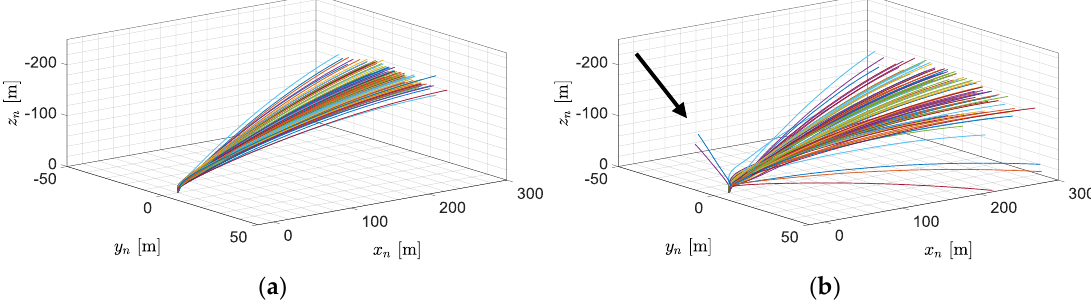
Figure 11. Projectile trajectories for various initial roll rate standard deviations. (a) 10°/s; (b) 60°/s. In the worst-case scenario (Figure 11b, black arrow), the trajectories are far from the desired direction. Such a situation is undesirable in real firings for safety reasons.